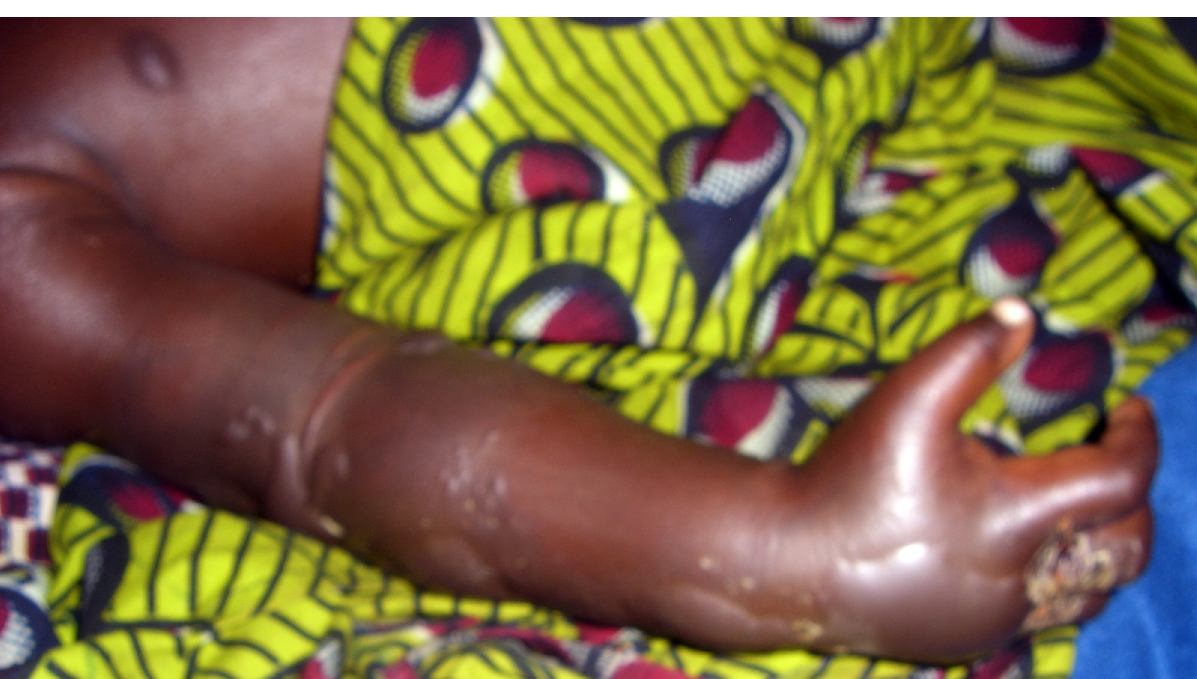
Figure 1. Initial examination showed that the right hand and forearm were swollen.